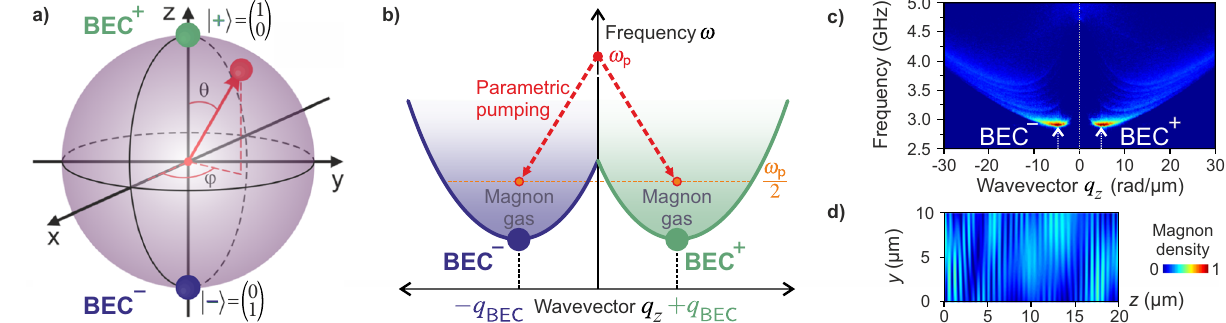
Fig. 1 System of two magnon Bose – Einstein condensates (BECs). a The green and blue dots at the north and south poles of the Bloch sphere represent pure þj i and (cid:2)j i states of the double magnon condensate BEC ± formed in two different global energy minima of the magnon system, while the red dot shows the position of a mixed state of BEC + and BEC − . b Schematic spectrum of magnons and BEC generation via parametric pumping using microwave photons of frequency ω p with small wavenumbers q p ≈ 0. The green and blue thick lines schematically depict the dispersion branches of the lowest- frequency magnon mode for the positive and negative wavevectors q z along the magnetization direction z . The red dashed arrows indicate the process of decaying the pump photon into two magnons of half the pump frequency and opposite wavevectors. The green and blue dots mark the spectral positions of the BEC + and BEC − formed in the two global energy minima at q z ¼ þ q and q z ¼ (cid:2) q . The green and blue shaded areas symbolize the corresponding BEC BEC magnon gaseous states. c Numerical simulation of the condensation process of parametrically populated magnon gas in an yttrium-iron-garnet (YIG) ferrimagnetic fi lm. The fi ne structure of the magnon gas population corresponds to the thickness magnon modes of this fi lm. The YIG fi lm-thickness is 5 μ m. The pumping frequency ω p /(2 π ) is 7.5 GHz with a pump duration of 50 ns. The bias magnetic fi eld is 100 mT. d Spatial interference pattern formed by the superposition of the BEC + and BEC − states along the magnetization direction z . The magnon density stripes along the perpendicular direction y correspond to the BEC wave fronts. The color code indicates the normalized magnon density in c and d . The quite regular structure of the interference pattern corresponds to a relatively high degree of spatial coherence of the magnon